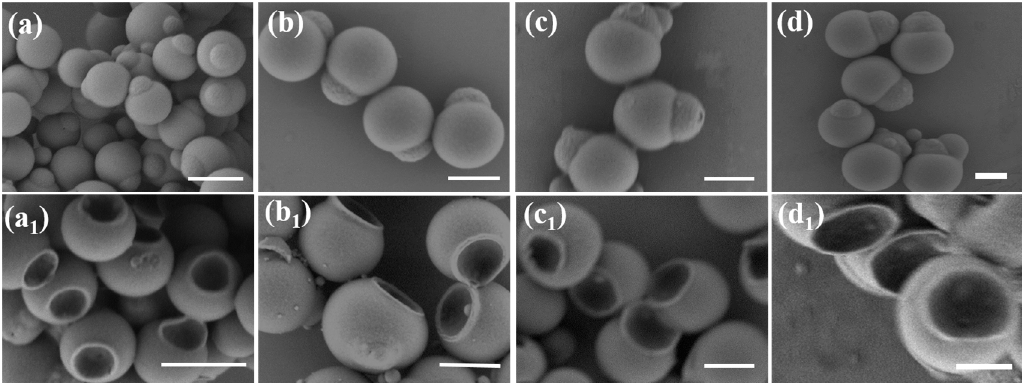
Figure 5. SEM images of SiO 2 @MPSQ particles prepared from silica templates with different particle diameters: ( a ) 243, ( b ) 426, ( c ) 550, and ( d ) 760 nm, with the corresponding bowl-shaped particles after etching with 5% HF. Scale bars: 500 nm. ( a1 – d1) are the SEM images of the bowl-shaped particles obtained after etching the snowman-like particles prepared by the silica template.